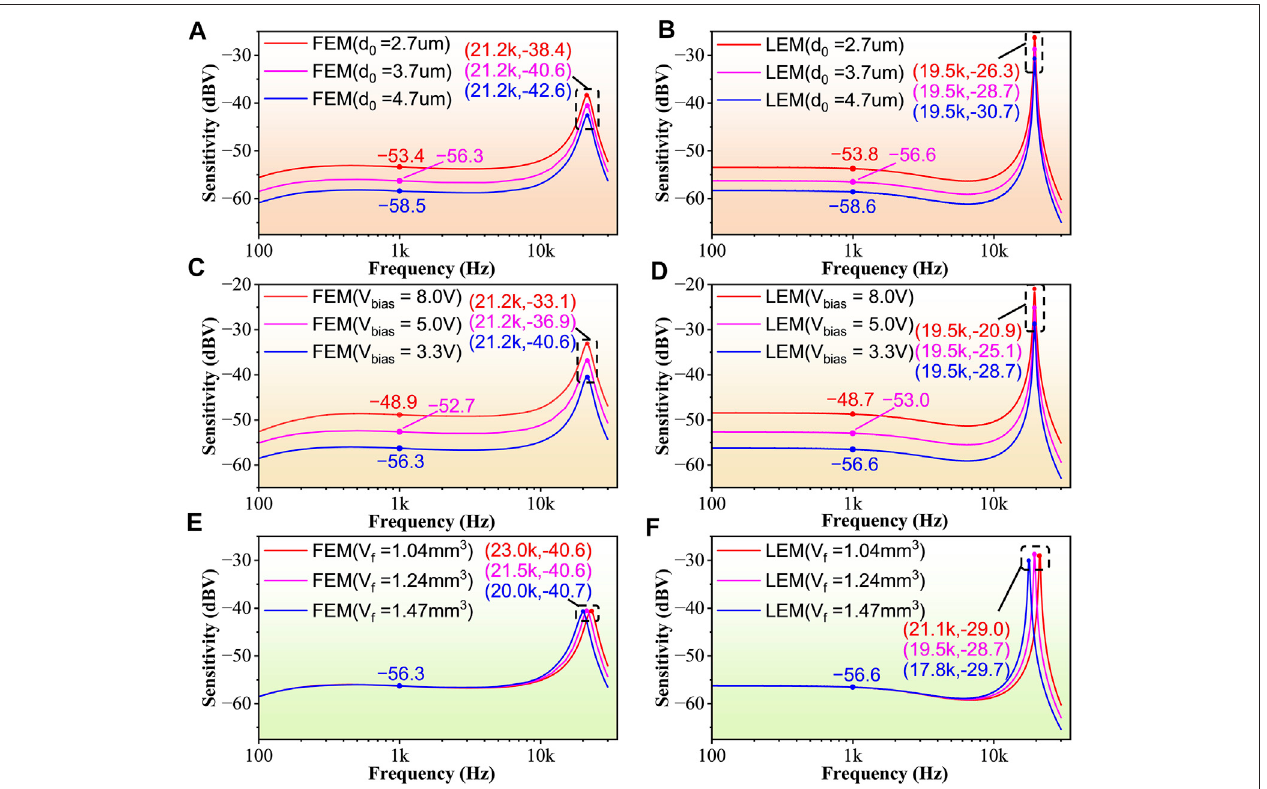
FIGURE 6 | Simulation of the frequency response of MEMS microphone with different parameters using the FEM and the LEM. (A) and (B) describe the in fl uences of air gap heights d 0 change. (C) and (D) describe the in fl uences of bias voltage V bias variation. (E) and (F) describe the in fl uences of the volume V f change of the front